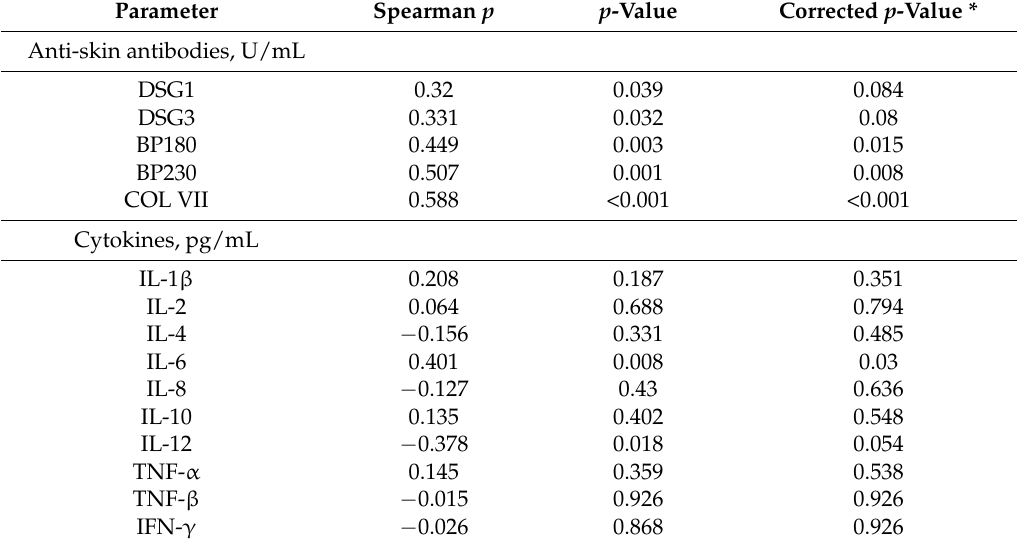
Table 5. Correlation between anti-skin antibodies, serum cytokine levels, and the Birmingham Epidermolysis Bullosa Severity (BEBS) score in inherited epidermolysis bullosa patients.